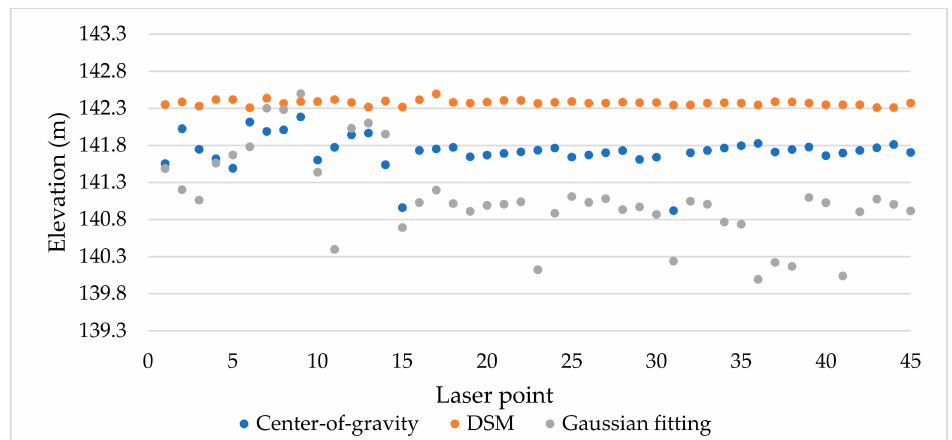
Figure 12. Comparison of the measured elevation values of the two methods in flat areas. The measured elevation values obtained by the COG method (blue) do not di ff er much from the values obtained by the Gaussian fitting method (gray).